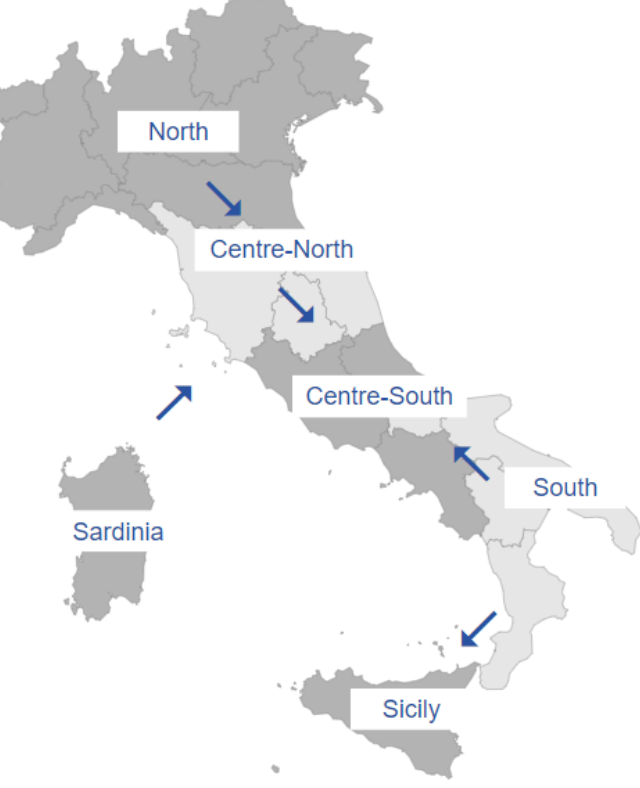
Figure 2. Electricity physical zones in force up to 31 December 2020 (Source: TERNA